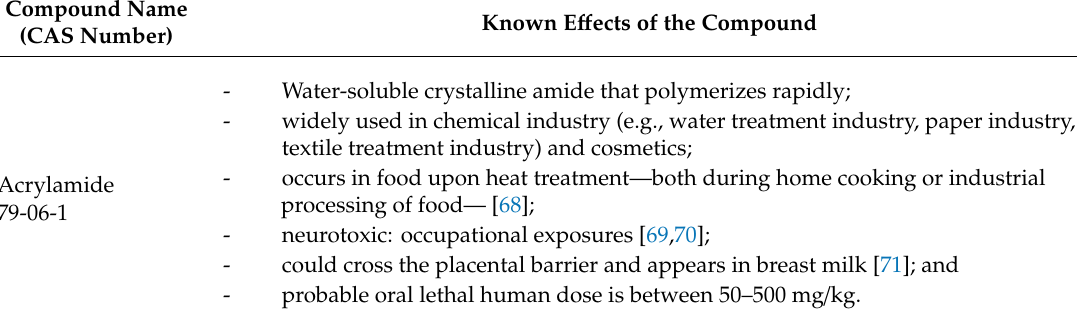
Table 1. Known e ff ects of the used